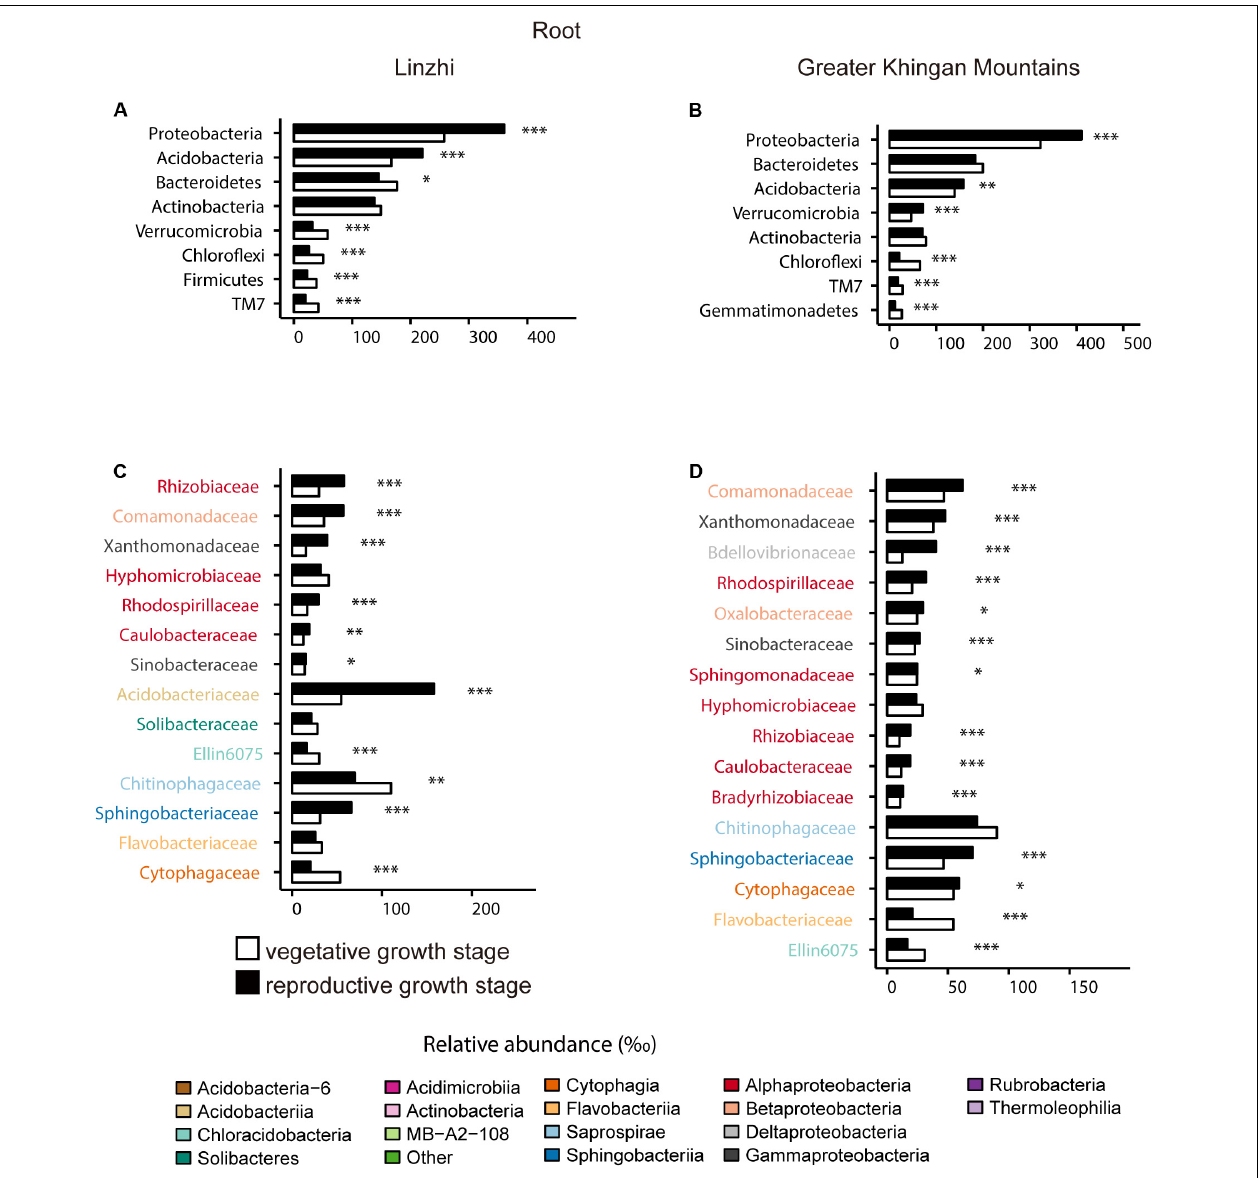
FIGURE 9 | Comparative analyses of bacterial core microbiome across different developmental stages. (A) Relative abundance